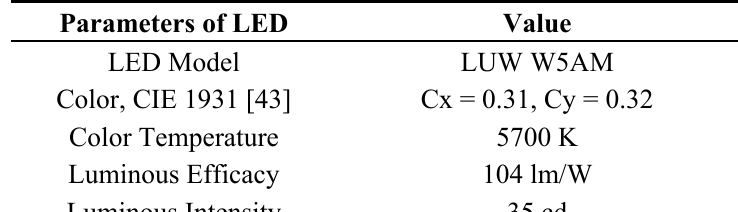
Table 3. Data sheet of OSRAM TM LED.